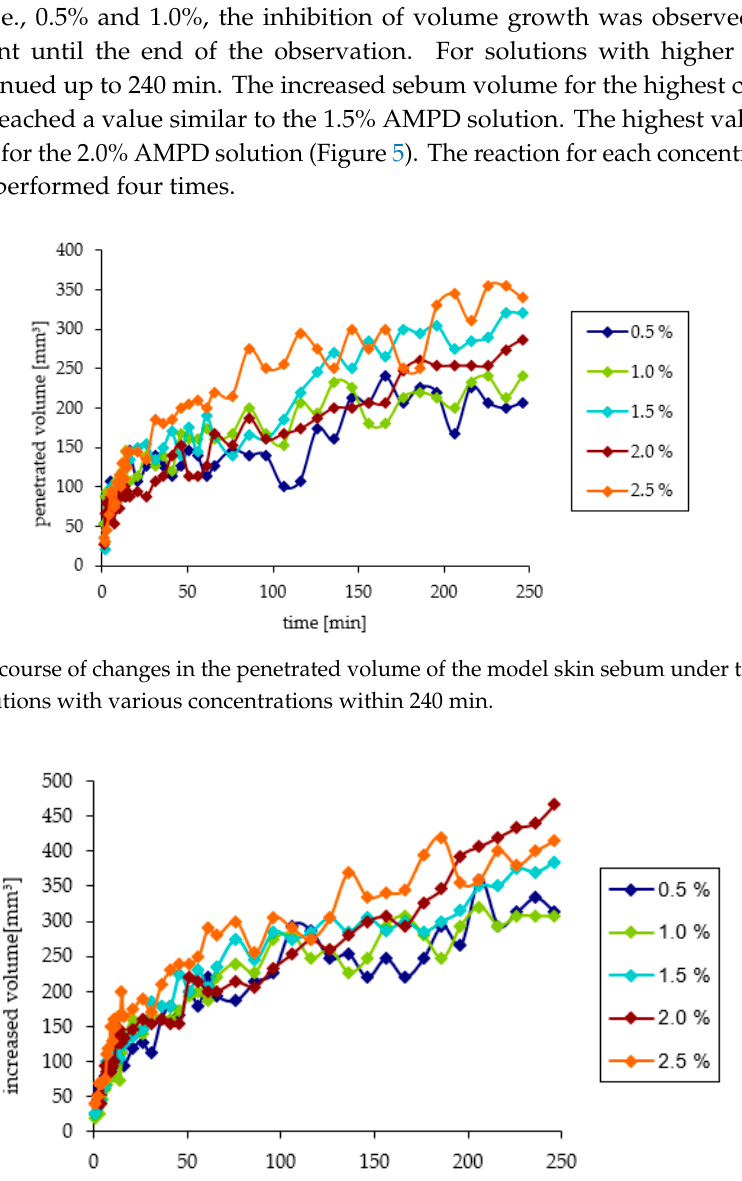
Figure 5. The course of changes in the increased volume of model skin sebum over the initial level under the influence of AMPD solutions with various concentrations within 240